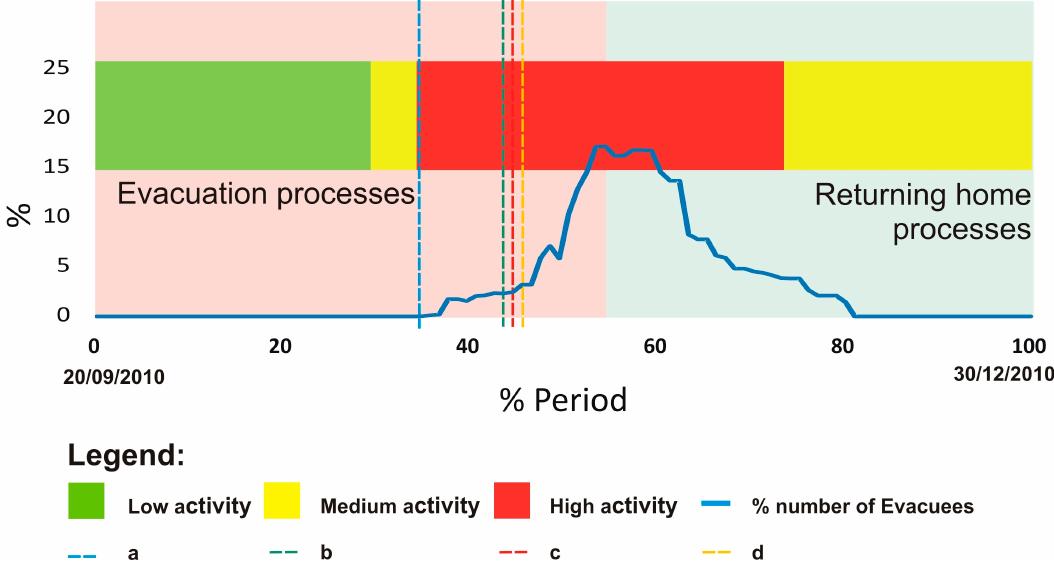
Figure 6. Temporal accumulation of evacuees during the crisis period in 2010. ( a ) Issuance of the first evacuation order on 25 October 2010; ( b ) issuance of a second evacuation order on 3 November 2010; ( c ) major eruption on 4 November 2010; and ( d ) issuance of a third evacuation order on 5 November 2010 (Adapted from [15,76]). Excel data: see Supplementary Material—Appendix 2.